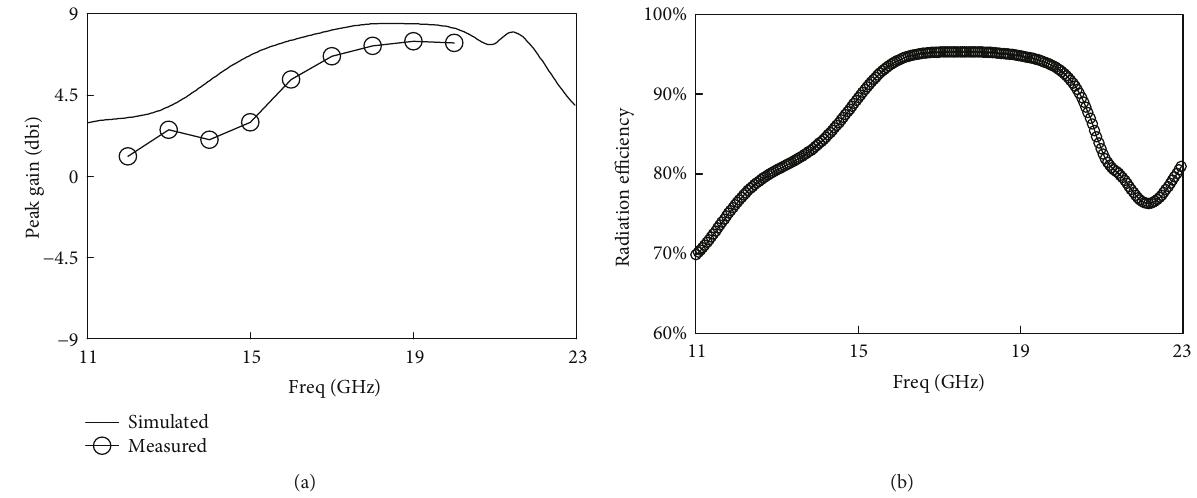
Figure 12: Variation of peak-realized gain (dBi) and radiation e ffi ciency with frequency: (a) peak-realized gain; (b) radiation e ffi ciency. Figure 12. The average simulated and measured gains of the proposed antennas are 8.1 dBi (with the peak of 8.5 dBi at 19.2 GHz) and 5.25 (with the peak of 7.49 dBi at 19 GHz), respectively. The comparison of antenna performance for di ff erent feeding techniques has been shown in Table 3.